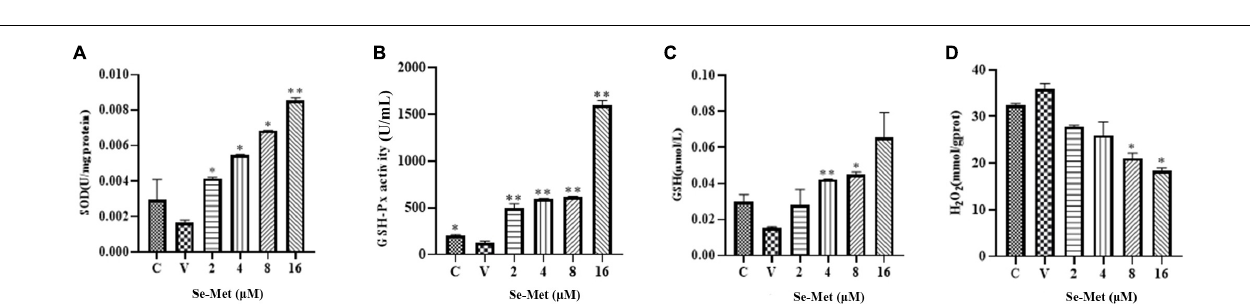
FIGURE 4 | Effects of Set-Met on the changes of oxidative/antioxidant indexes in cells induced by PDCoV. LLC-PK cells were incubated with PDCoV for 1 h, and 2, 4, 8, and 16 µ M of Se-Met was added. (A) Changes in SOD. (B) Changes in GSH-PX. (C) Changes in GSH. (D) Changes in H 2 O 2 . ∗ 0.01 < P < 0.05, ∗∗ P <